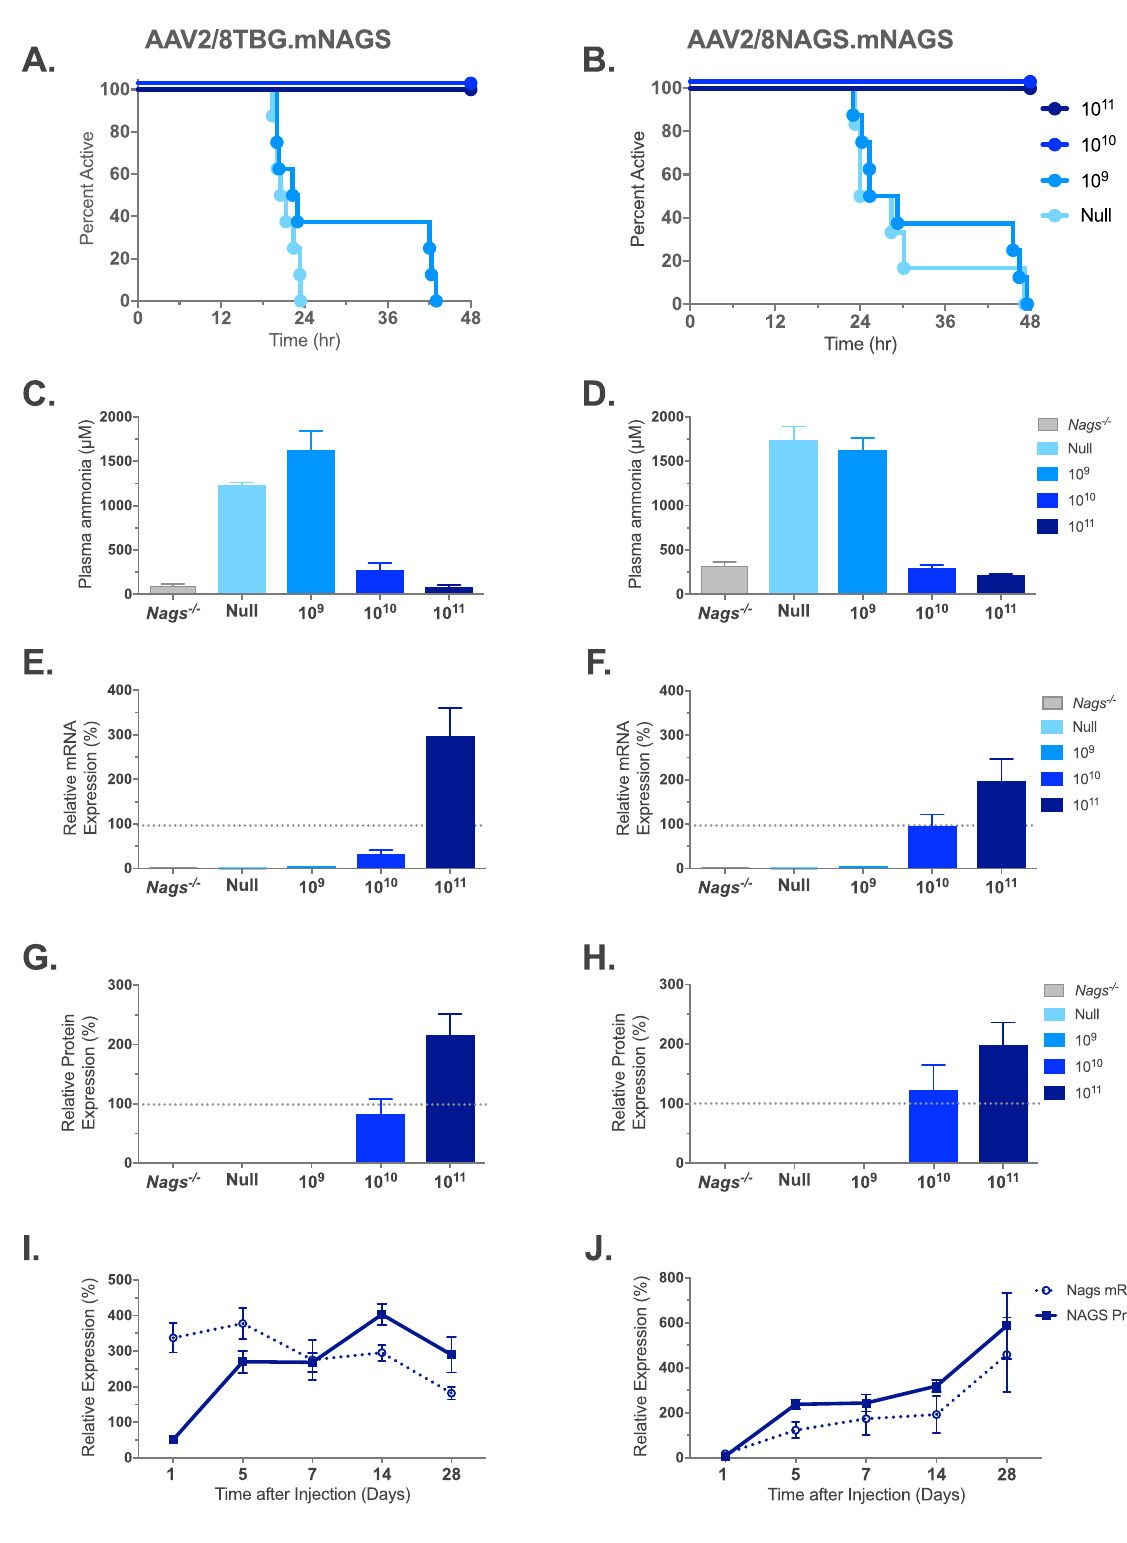
Figure 3. Phenotype of the Nags −/− mice after expression of the NAGS gene from the AAV2/8TBG.mNAGS vector (left panels), or the AAV2/8NAGS.mNAGS vector (right panels). ( A , B ) Duration of activity on the voluntary wheel. ( C , D ) Plasma ammonia concentrations. ( E–H ) Abundance of the Nags mRNA ( E , F ) and NAGS protein ( G , H ) in the liver. ( I , J ) Changes in the abundance of Nags mRNA and NAGS protein in the liver after a single injection of 10 11 viral particles. Each column in panels E–H represents a mean and its associated SEM in n = 8 mice; each data point in panels I and J represents a mean and its associated SEM in n = 6 mice where 100% is set as the mean value for four Nags + / + mice in panels E–H. Abundance of the Nags mRNA and NAGS protein in injected and Nags + / + mice were normalized to the abundance of 18S rRNA and vinculin,